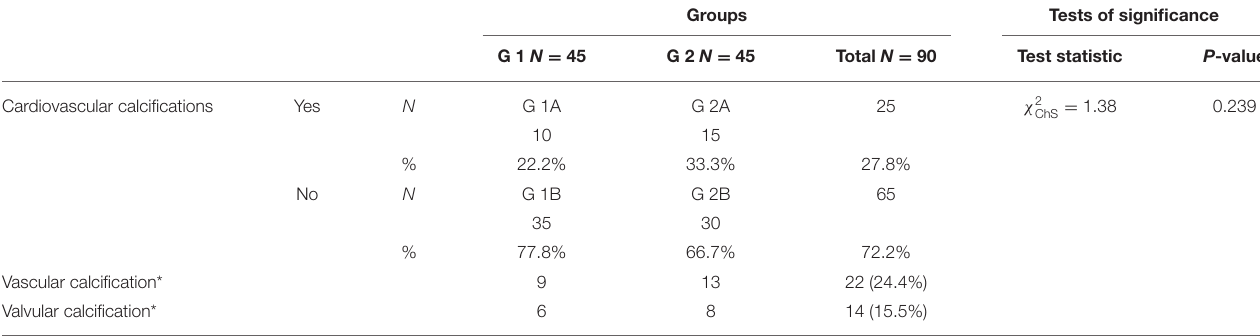
TABLE 1 | Classification of the studied population according to distribution of cardiovascular